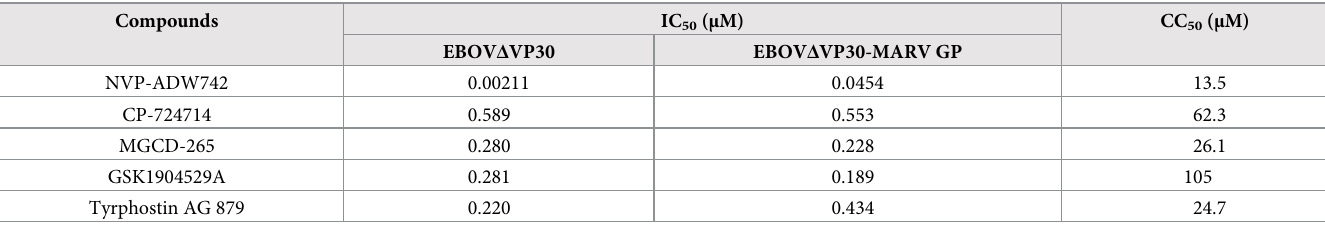
Table 1. Inhibitory concentration (IC 50 ) and cytotoxicity (CC 50 ) of selected compounds. Compounds